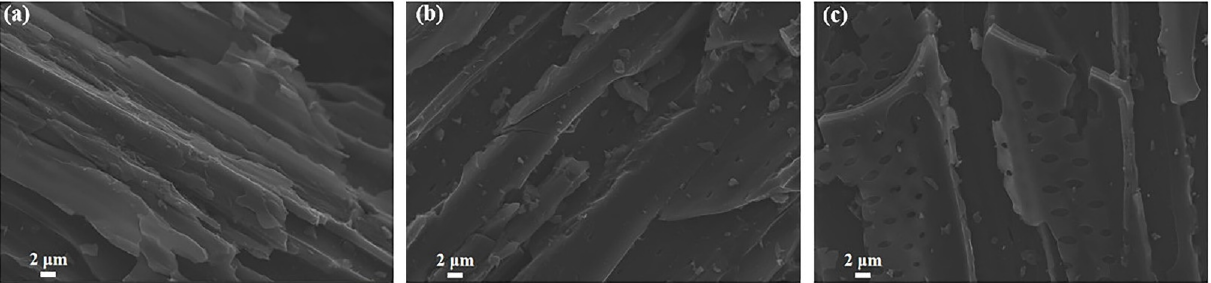
Figure 1. SEM images of ( a ) WR; ( b ) FWR; ( c )